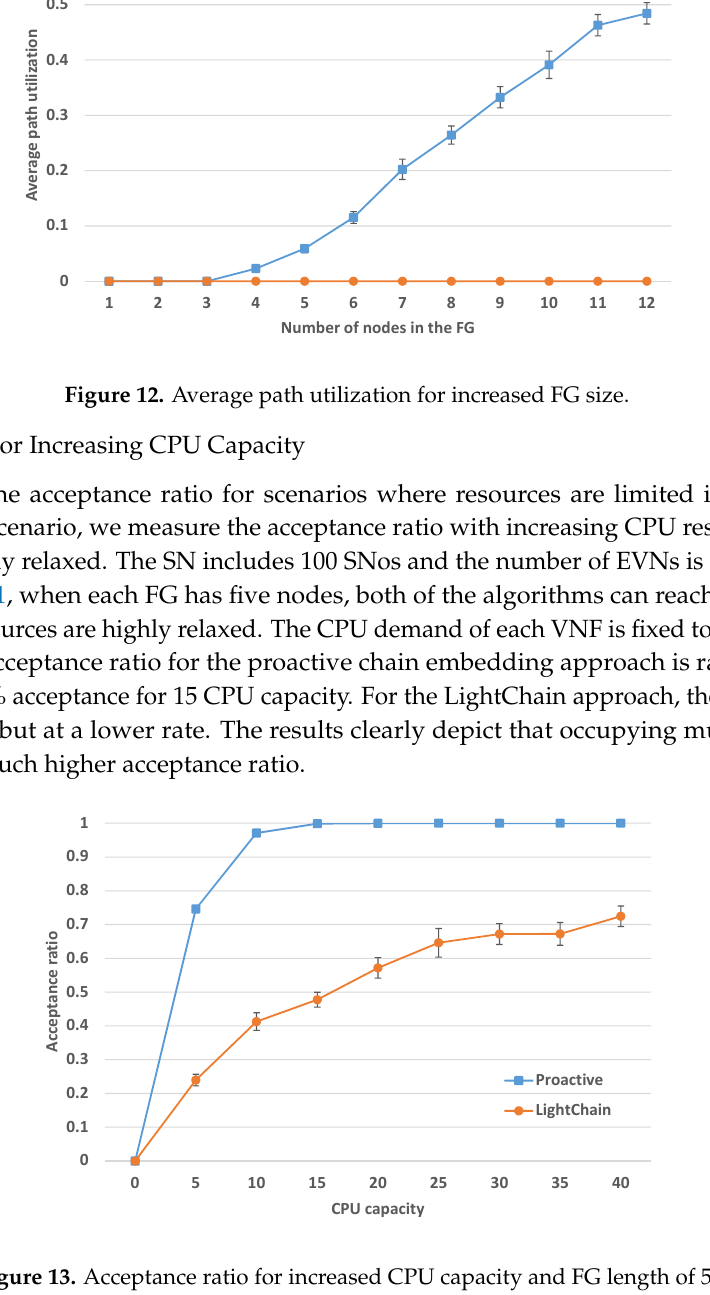
Figure 13. Acceptance ratio for increased CPU capacity and FG length of